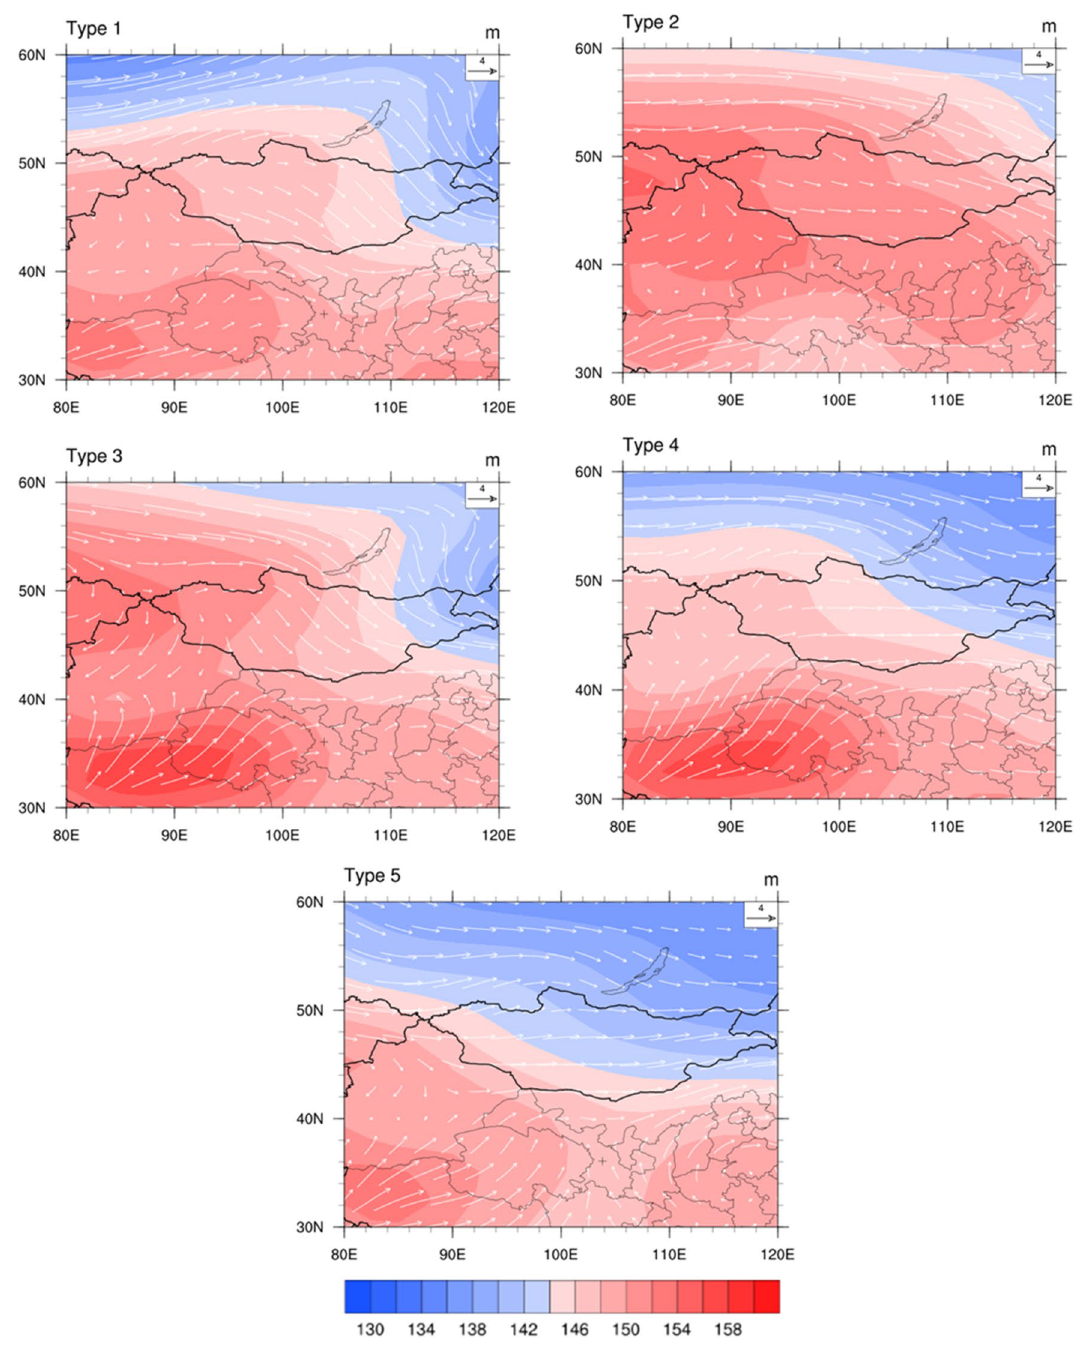
Figure 6. 850 hPa geopotential height fields and wind vector fields of typical synoptic circulation from March 1, 2021, to May 31, 2021 (cross indicates Lanzhou, China) (NCAR Command Language https:// www. ncl. ucar.